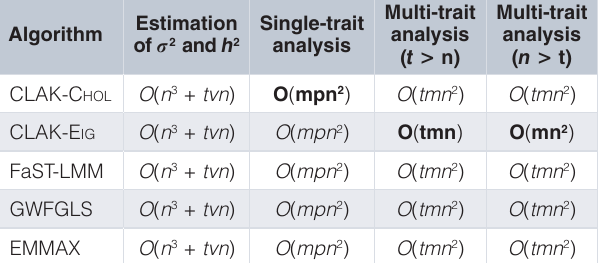
Table 1. Computational costs for the solution of single-trait and multiple-trait analyses. The variables n , m and t denote the sample size, the number of genetic markers, and the number of traits, respectively. v is the average number of iterations necessary to estimate the model parameters σ 2 and h 2 (see “Time complexity” in Supplementary Note S1). Multi-trait Estimation Single-trait Algorithm of σ 2 and h 2 analysis